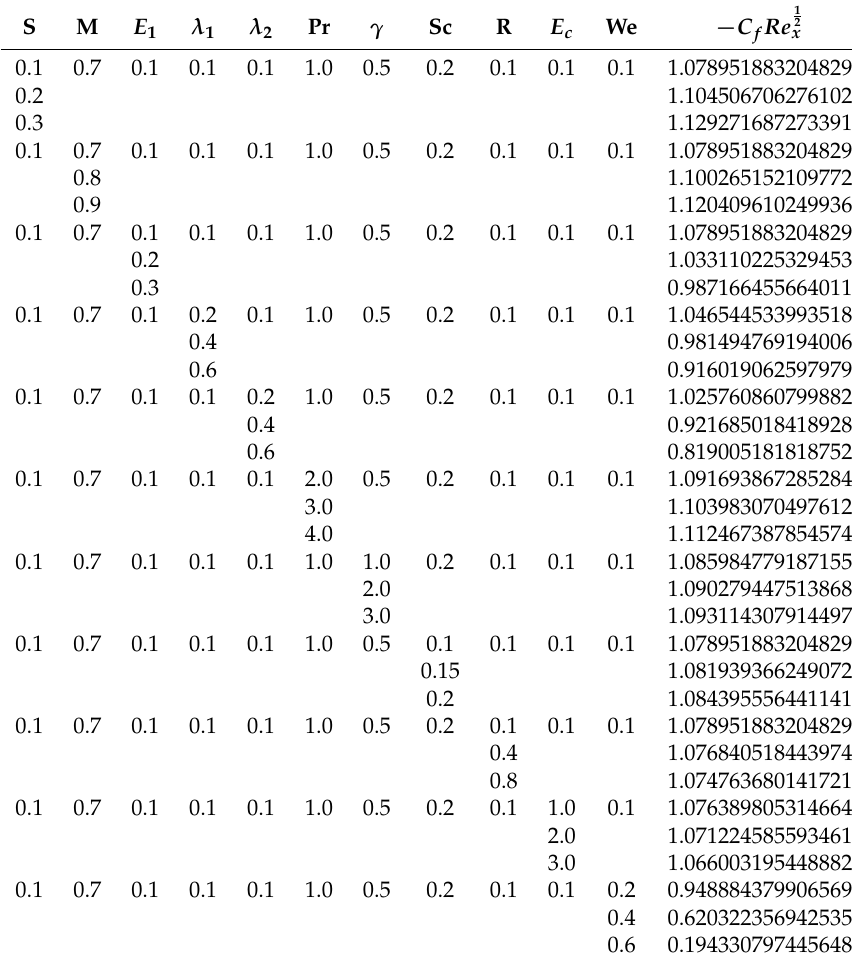
Table 1. The numerical values of C f Re R , E c , γ and Sc when η = 0.5.